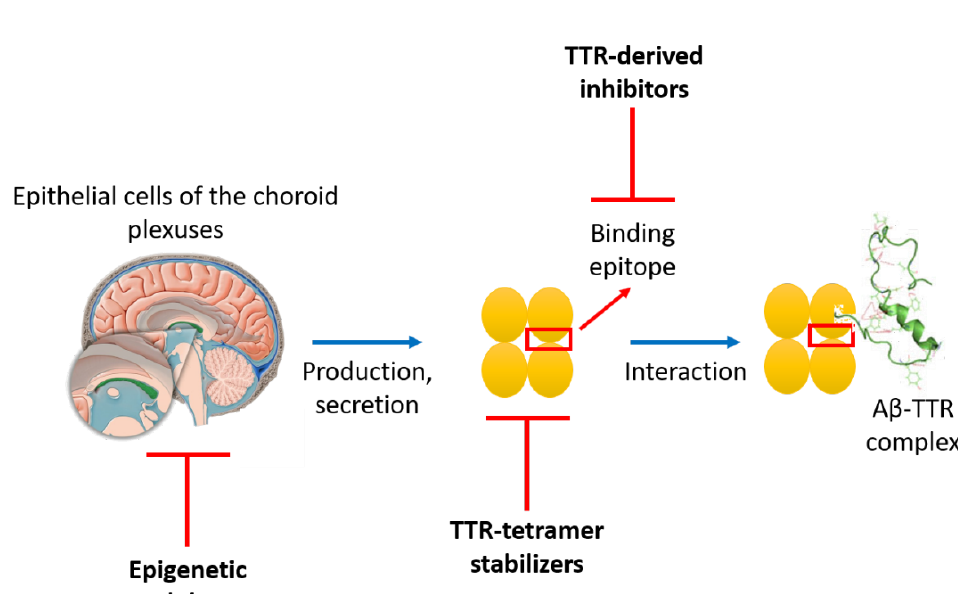
Figure 3. Schematic representation of the three different strategies employed to design anti-Aβ agents based on TTR-Aβ interactions.